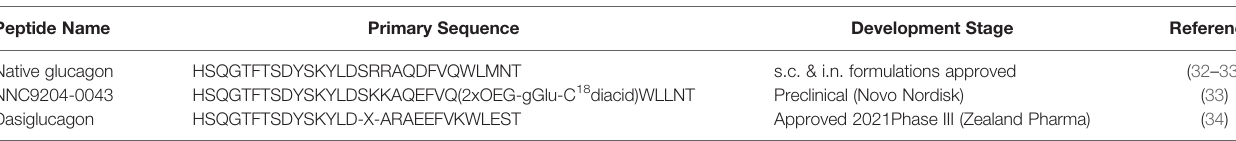
TABLE 1 | Glucagon and related analogues in the management of hypoglycaemia in